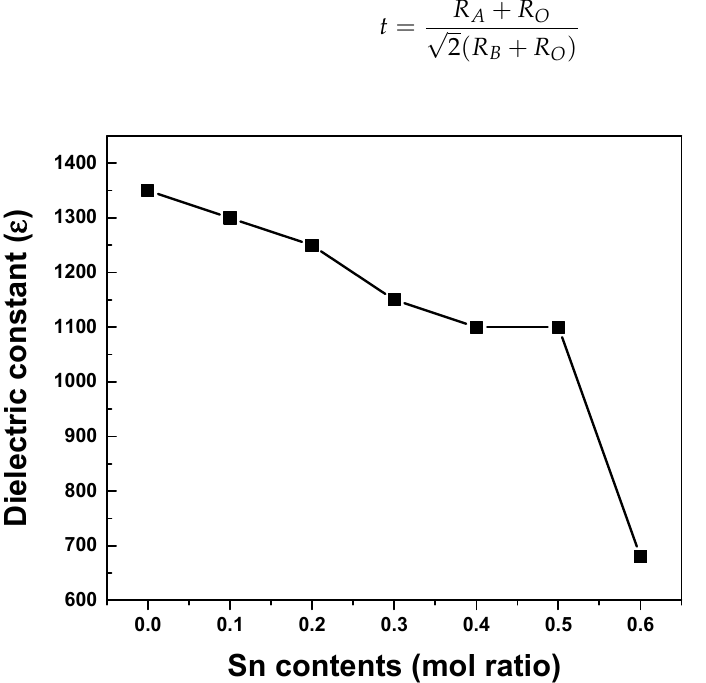
Figure 6. Dielectric constant of (Pb 0.88 , La 0.12 )(Zr 1 − x , Sn x ) 0.86 Ti 0.14 O 3 composition according to the amounts of Sn 4+ substitution.